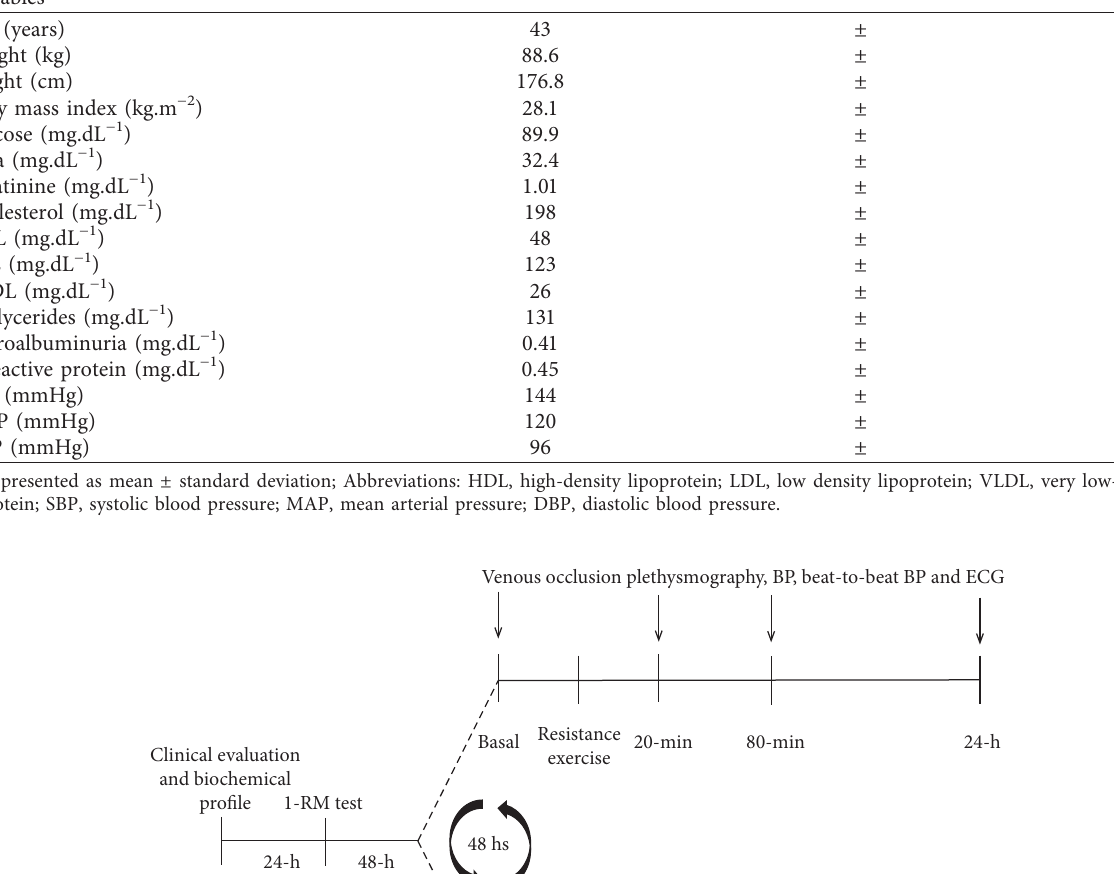
Table 1: Anthropometric, metabolic, and hemodynamic characteristics of subjects with untreated stage 2 hypertension ( n � 10). Variables